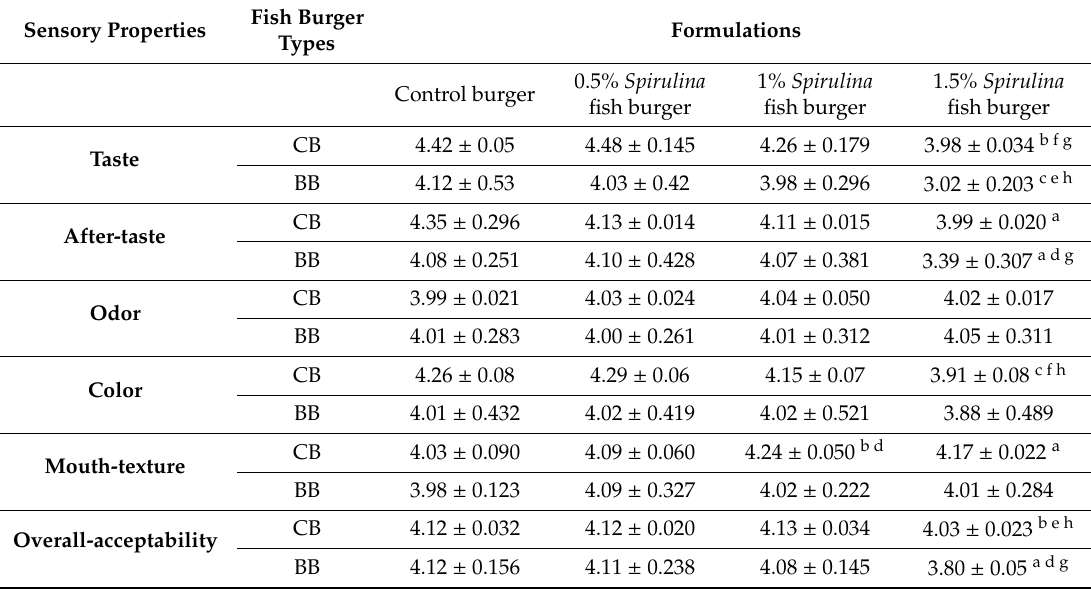
Table 1. Mean scores of tasting panelists (n = 30) for sensory properties of control and fortified